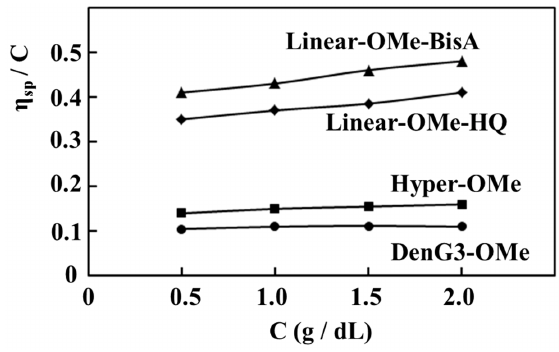
Figure 3. Reduced viscosities of DenG3-OMe , Hyper-OMe , Linear-OMe-BisA , and Linear-OMe-HQ .